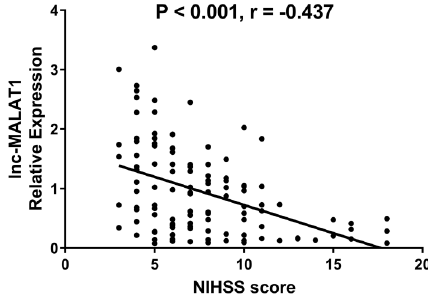
Figure 2. lnc-MALAT1 high expression was correlated with decreased NIHSS score (Spearman rank test). lnc-MALAT1: long non-coding RNA metastasis-associated lung adenocarcinoma transcript 1; NIHSS score: National Institutes of Health Stroke Scale